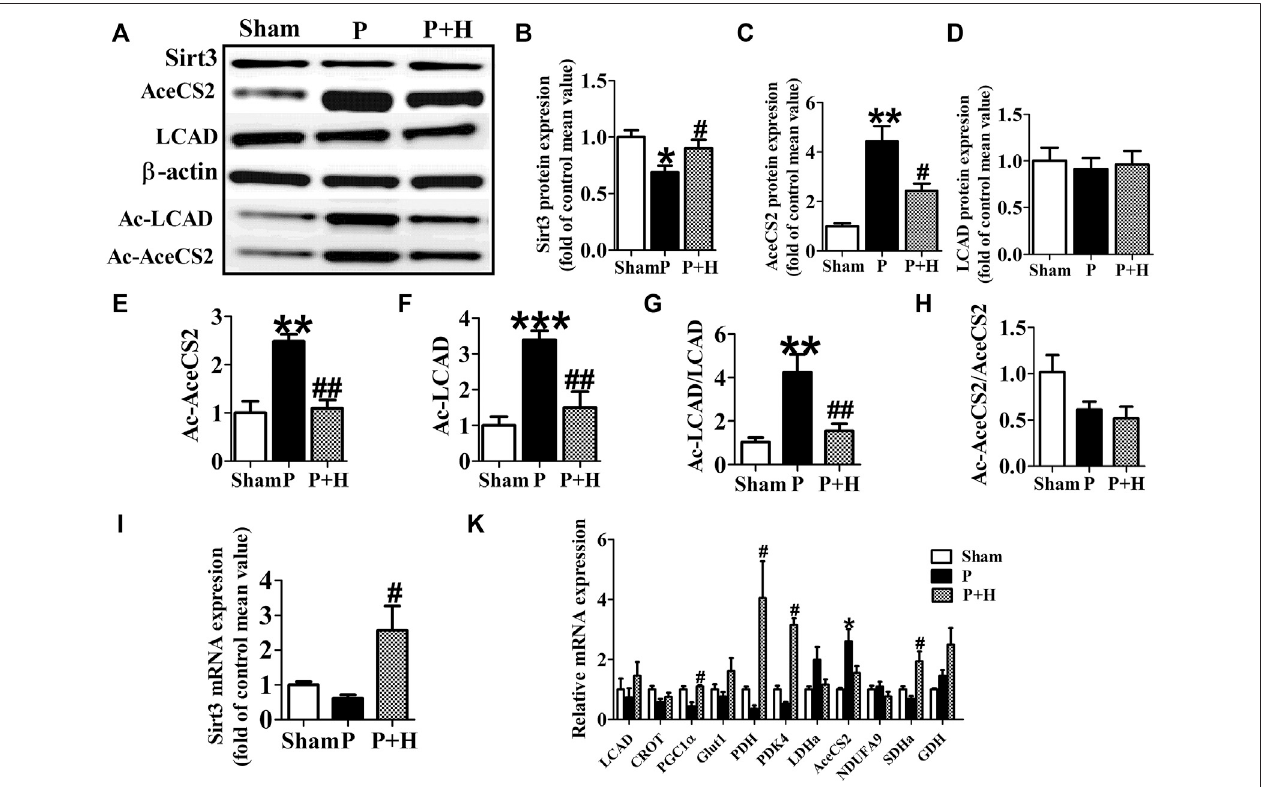
FIGURE 3 | HL inhibited the remodelling ofmetabolic factors and acetylationlevel ofkey metabolic enzyme in rabbit ofAFmodel. (A) Representativebands ofprotein expressionofSirt3,AceCS2,Ac-LACDandAc-AceCS2. (B,C,D,E,F) Quanti fi cationanalyzingofproteinexpressionofSirt3,AceCS2,Ac-LACDandAc-AceCS2. (GandH) StatisticalresultsforratioofAc-LCAD/LCADandAc-AceCS2/AceCS2. (I) StatisticalresultsforexpressionofSirt3gene. (K) StatisticalresultsforexpressionofLCAD,CROT, PGC1 α ,PDH,PDK4,LDHa,AceCS2,NDUFA9,SDHaandGDHgenes.Datafromtheseproteinswerenormalizedto β -actin,andgeneswerenormalizedto β -actin.* p < 0.05 vs. sham group, ** p < 0.01 vs. sham group, *** p < 0.001 vs. sham group; # p < 0.05 vs. P group, ## p < 0.01 vs. P group, n = 6 each